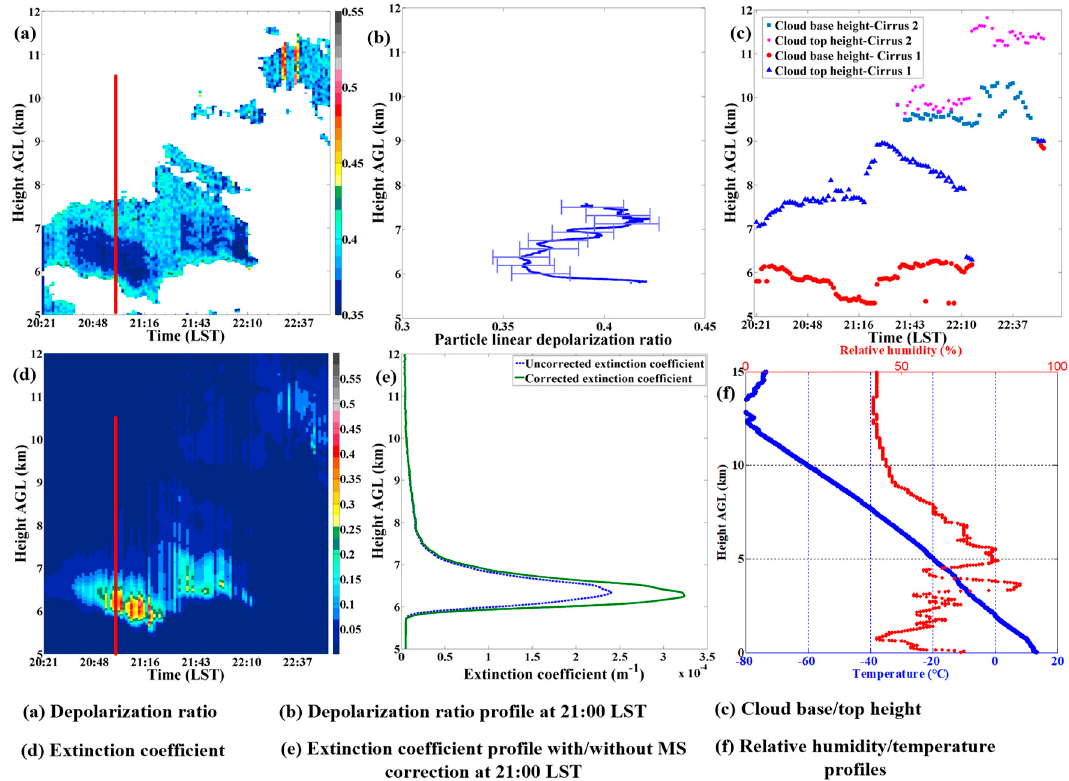
Figure 2. Time serials of ( a ) depolarization ratio, ( b ) one depolarization ratio profile, ( c ) cloud base/top heights on 04 August 2014. In this figure, ( d ) extinction coefficient and ( e ) one extinction coefficient profile measured at 21:00 LST are provided, as well as the ( f ) relative humidity/temperature. Please note that only the depolarization ratios inside of the cirrus are provided. In the Figure ( d ), the extinction coefficient with multiple scattering correction and without the correction are plotted and the results are denoted by dark green solid line and blue dashed line, respectively.